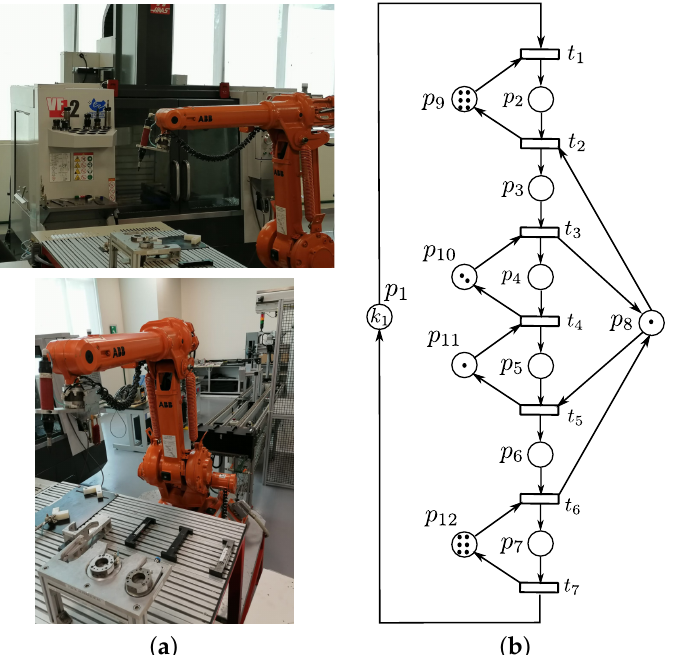
Figure 1. A manufacturing cell and its Petri net model. ( a ) Manufacturing cell. ( b ) Manufacturing cell model.